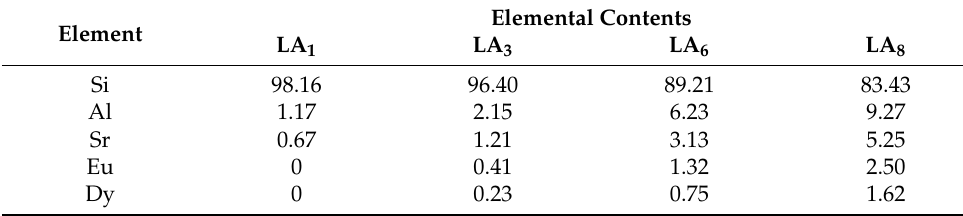
Table 2. Elemental compositions (wt%) of LANPs-loaded GLS@PET as detected by XRF.